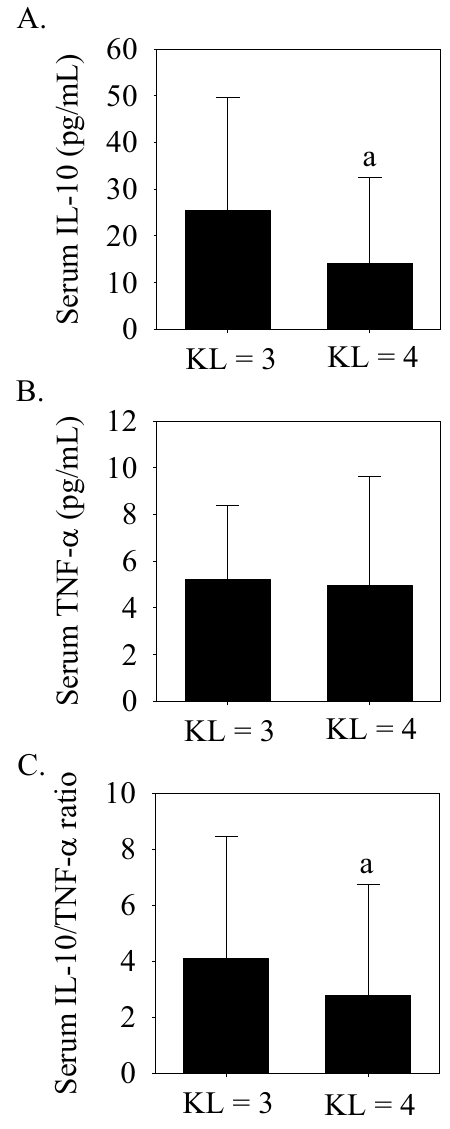
Figure 3. Serum IL-10 and TNF-α concentrations and the serum IL-10/TNF-α ratio with a KL grade = 3 (moderate knee osteoarthritis, ≤ 50% joint space narrowing, n = 49) compared to a KL grade = 4 (severe knee osteoarthritis, > 50% joint space narrowing, n = 30). ( A ) Serum IL-10 was significantly ( a p < 0.05 vs. KL grade = 3) lower with a KL grade = 4. ( B ) Serum TNF-α concentrations were not significantly different between groups. ( C ) The serum IL-10/TNF-α ratio was significantly ( a p < 0.05 vs. KL grade = 3) lower with a KL grade = 4. Data presented as median (interquartile range).